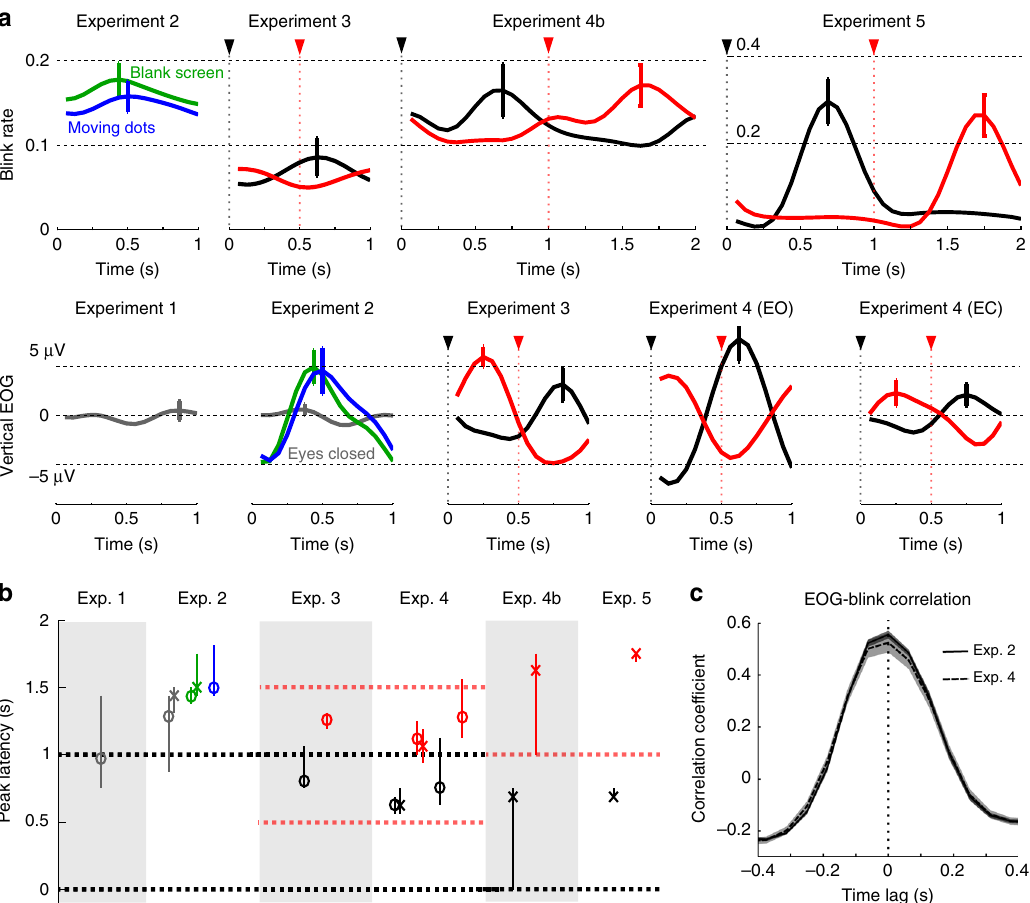
Fig. 9 Waveform of the blink rate and vertical EOG within each high-level structure in Experiments 1 – 5. a Timecourses of the blink rate and vertical EOG within each high-level structure. For Experiments 3 – 5, the onset of the attended unit is denoted by a triangle on the top. Black color represents conditions when attention is directed to the beginning of the structure while red color represents conditions when attention is directed to the midpoint of the structure. Other conditions are labeled in the fi gure. In Experiment 4, when the eyes are closed, clear phase opposition between conditions is only observed near the end of each trial (Fig. 4f) and therefore only the last 3 s of responses in each trial are averaged in this analysis. In Experiment 5, the response is aligned based on the 5th shape, which therefore is at time 0. b The time lag at which the blink/EOG signal reaches its maximal. Since the sequence structure is periodic, the estimated time lag could be advanced or delayed by an integer number of sequence periods. The error bar shows the 95% con fi dence interval, evaluated using bootstrap. In the bootstrap procedure, time lags from resampled data are converted into phase angles and averaged using the circular mean. c The cross-correlation function between single-trial blink signal and vertical EOG. A positive correlation is observed at time lag 0 in Experiments 2 and 4, in which EOG and eyetracking are simultaneously expression. In block 5, a normal trial presented 48 random syllables while in an contained four other experimental conditions using speech materials with different outlier trial four consecutive syllables at a random position were replaced by a linguistic structures (pairs of nouns) and the results would be reported separately. sentence. At the beginning of each trial, instructions were given about what kind of Experiment 1: Thirty trials were presented. In 50% trials, the last two syllables of trials were normal or outlier trials. After each trial, the participants pressed the sentence sequence were removed so that the last sentence only consisted of a different keys to indicate outlier trials or normal trials. After the key press, the next two-syllable noun phrase. After each trial, the participants pressed different keys to trial was presented after a silent interval randomized between 1 and 2s (uniform indicate whether all sentences were complete or one of them was truncated. The distribution). Before the experiment, participants listened to two sample trials to participants made a correct response in 97± 1% trials (mean ± SEM across get familiar with the tasks. participants). After the key press, the next trial was presented after a silent interval Experiment 3: Each trial began with a bisyllabic word that was randomly chosen randomized between 1 and 2 s (uniform distribution). Before the experiment, the from six candidates, i.e., /dà dì/, /f ē ng fù/, /g ǎ i gé/, / háo huá/, / k ā ng k ǎ i/, and /y ī n participants were familiarized with one normal trial and one outlier trial that were yuè/, with equal probability. 1s after the bisyllabic word, a 11-s sentence sequence not used in the experiment. was presented (Supplementary Fig. 2). The bisyllabic word consisted of two Experiment 2: The experiment was divided into fi ve blocks. Each block syllables that shared the same initial consonant and the shared initial consonant consisted of 35 trials and fi ve of them were outlier trials that were not included in was de fi ned as the target consonant. The experiment was divided into two blocks. the EEG or eyetracking analysis. Blocks 1 – 4 presented sentence materials while In one block, the participants were asked to attend to the 1st syllable in every block 5 presented random syllables. Blocks 1 and 2 were identical, which construct sentence and detect if the target consonant was the initial consonant of any the main condition in the experiment. In the fi rst 2 blocks and also block 5, the attended syllable. In the other block, the participants did the same consonant participants freely viewed random dots moving on a monitor. In blocks 3 and 4, the detection task but attended to the 3rd syllable of every sentence. The order of the monitor and light was turned off. The participants kept their eyes open in block 3 two blocks was counterbalanced across participants. Each block contained 60 trials. and closed in block 4. Each block contained 35 trials. Block 1 was always presented In each sentence sequence, one and only one sentence contained a syllable fi rst to investigate if the ocular response adapted over time. The order of blocks 2 – 5 starting with the target consonant. That syllable, however, might appear as the 1st, was randomized. 2nd, 3rd, or 4th syllable of that sentence with equal probability (i.e., 15 trials for In blocks 1 – 3, normal trials contained 12 sentences while the outlier trials were each position). When the target consonant appeared at the attended position (the identical to the normal trials except that the four syllables of a randomly chosen 1st syllable in one block and the 3rd syllable in the other block), the participant sentence were shuf fl ed. The shuf fl ed syllables did not construct any meaningful